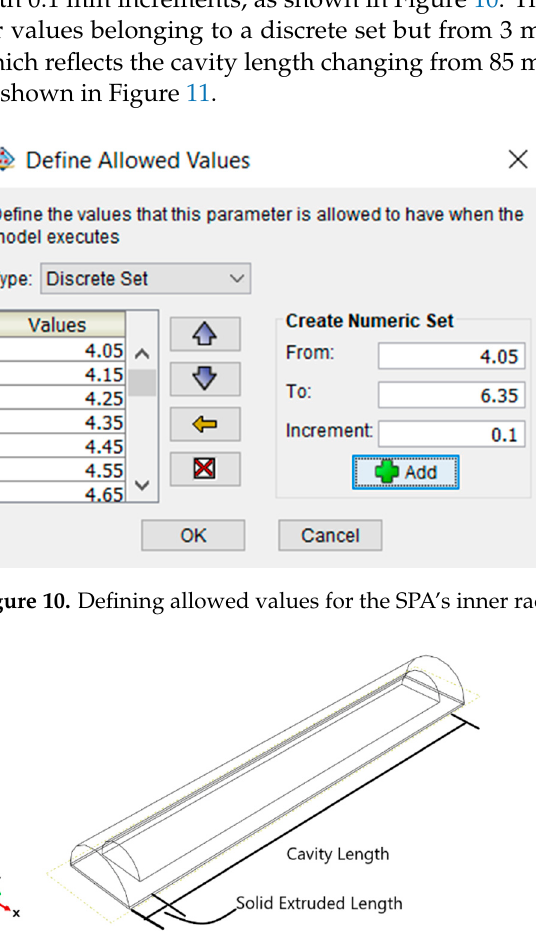
Figure 11. The relation between solid extruded length and cavity length.